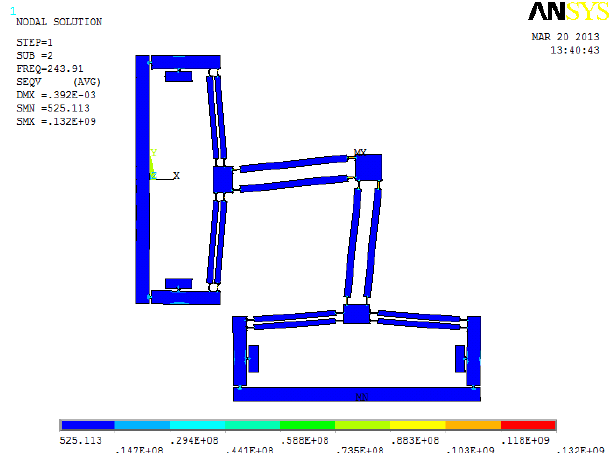
Fig. 6. Contour plot of the Von-Mises stress of the optimized CMDA Figure 6. Contour plot of the Von-Mises stress of the optimized